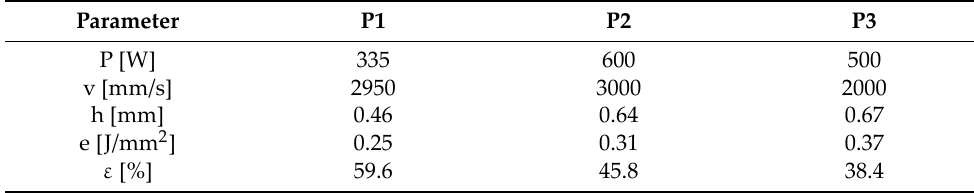
Table 3. Printing parameters for porous